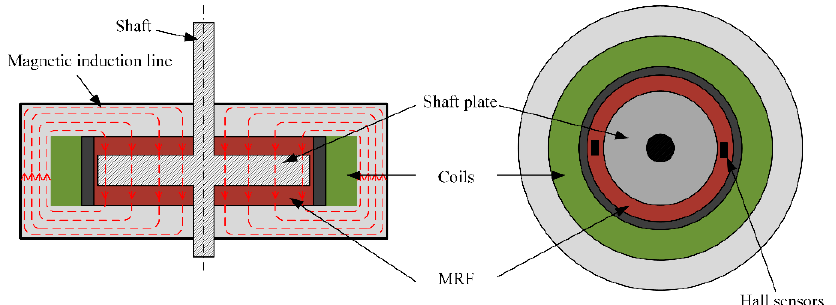
Figure 5. Schematic diagram of disc and magnetic susceptibility lines.